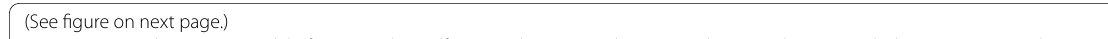
figure on next Fig. 7 Structural equation model of NO 3 − and pH effects on aboveground tree growth rate and root morphologies. A Structural equation model of Q. acutissima ( χ 2 12.033; df 10, p 0.283 > 0.05; GFI 0.951 > 0.900; RMSEA 0.068 < 0.080). B Structural equation model of C. lanceolata = = = = = ( χ 2 12.627; df 11, p 0.318 > 0.05; GFI 0.951 > 0.900; RMSEA 0.058 < 0.080). Numbers on lines are standardized path coefficients. The widths = = = = = of lines indicate the strength of the causal influence. Solid lines represent the direct effects on plant growth rates and root growth, dotted lines represent the effects on root physiologies. pH, AR pH; NO 3 − , the concentration of NO 3 − in AR; HGR, height growth rate; DGR, basal diameter growth rate; TRL, total root length; TRS, total root surface area; TTC, root activity; SOD, activity of superoxide dismutase in root; POD, activity of peroxidase in root; CAT, activity of catalase in